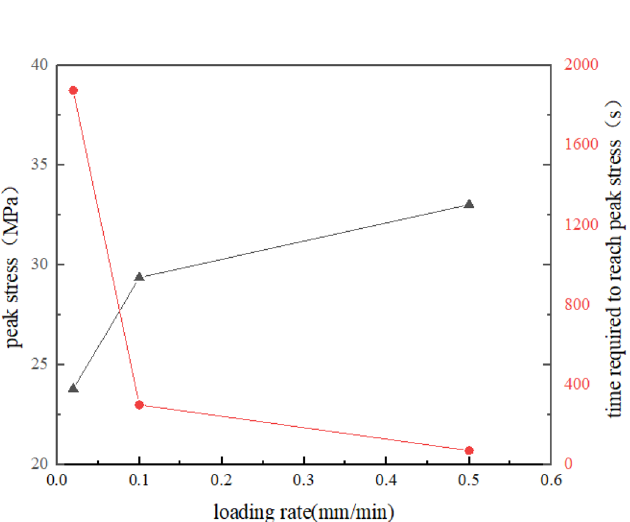
Table 2. Test results in different strain rates under uniaxial compression.